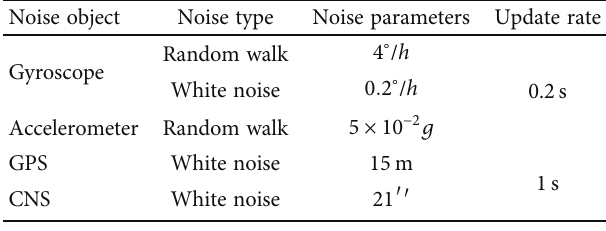
Table 1: Error parameter setting.